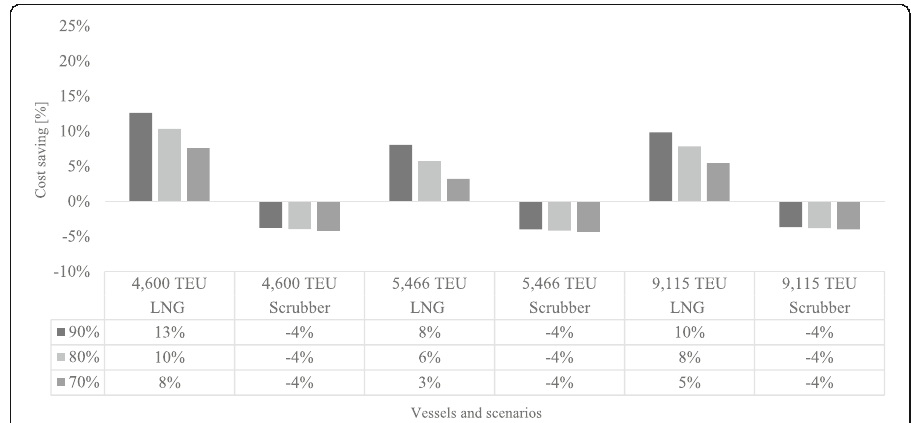
Fig. 8 Relative changes for the maritime cost (vessel owner ’ s cost) from the US to EU for different ship types and for LNG and scrubber scenarios (by increasing the price of LNG and decreasing the price of